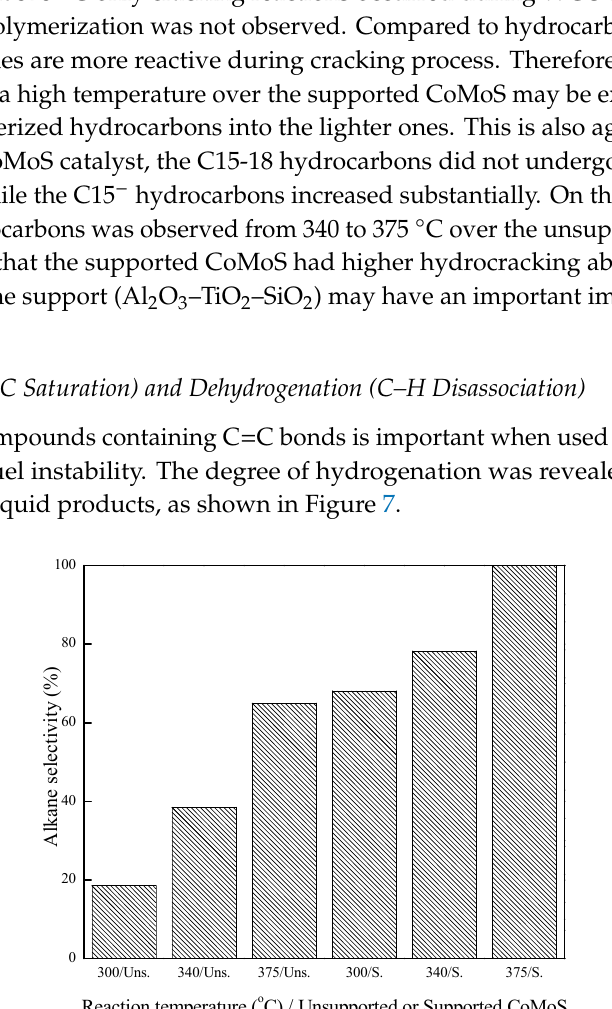
9 of 14 Figure 6. Hydrocracking and polymerization reactions during WCO hydrotreating processes. All liquid products were primarily composed of C15–18 (over 80%). Reaction temperature was a key factor in the cracking/polymerization of WCO hydrotreating using a CoMoS catalyst. Bezergianni et al. made the same observation [1,2,23,40]. When the reaction temperature increased from 300 to 375 °C over the unsupported CoMoS, the product fraction of hydrocarbons that were